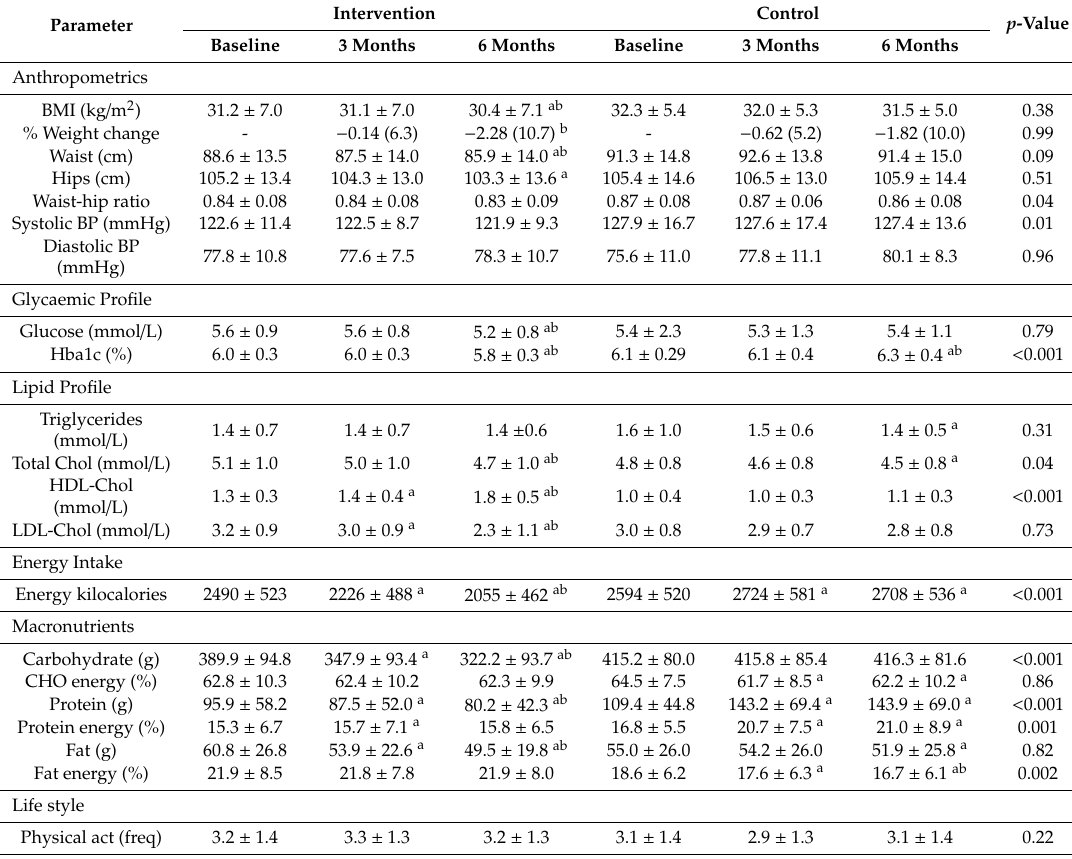
Table 3. Within and between group comparisons according to anthropometric, clinical, dietary intake and lifestyle across time points in all completing